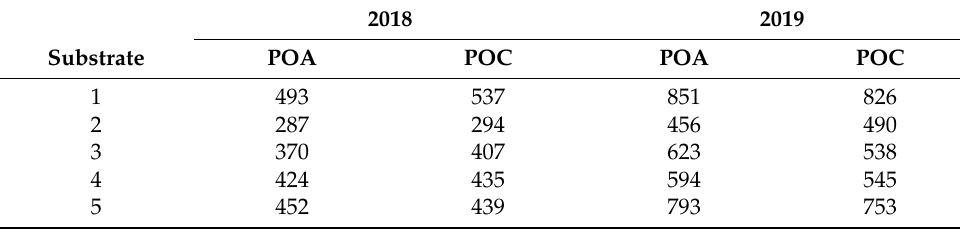
Table 2. Mushroom production (expressed in grams) on the different substrates tested.